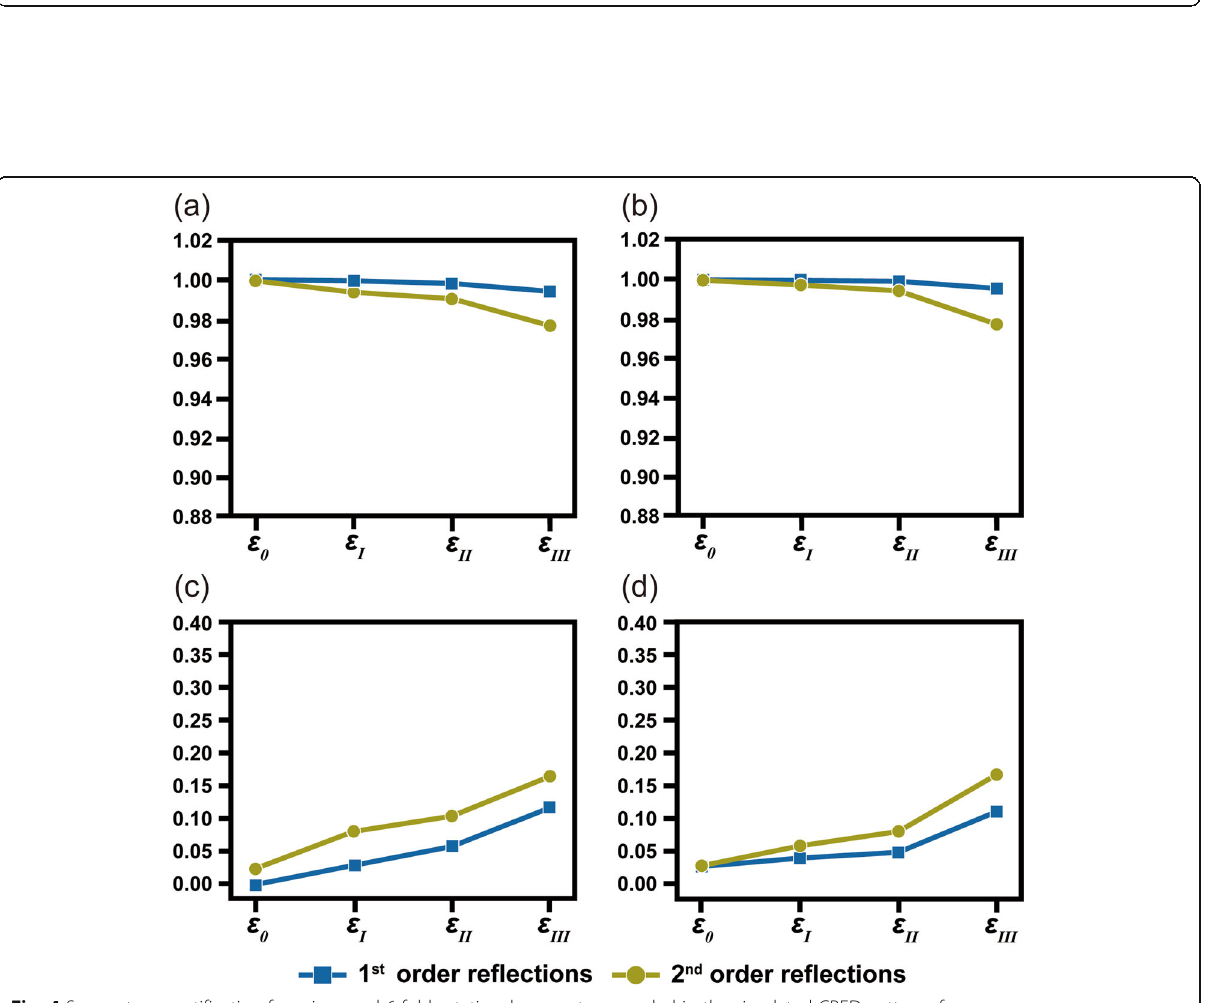
Fig. 4 Symmetry quantification for mirror and 6-fold rotational symmetry recorded in the simulated CBED patterns for ε 0(0%, 0%, 0%) , ε I(0.5%, 0.5%, − ε ε 0.25%) , II(1%, 1%, − 0.5%) , III(2%, 2%, − 1%) . The symmetry elements are respectively quantified based on